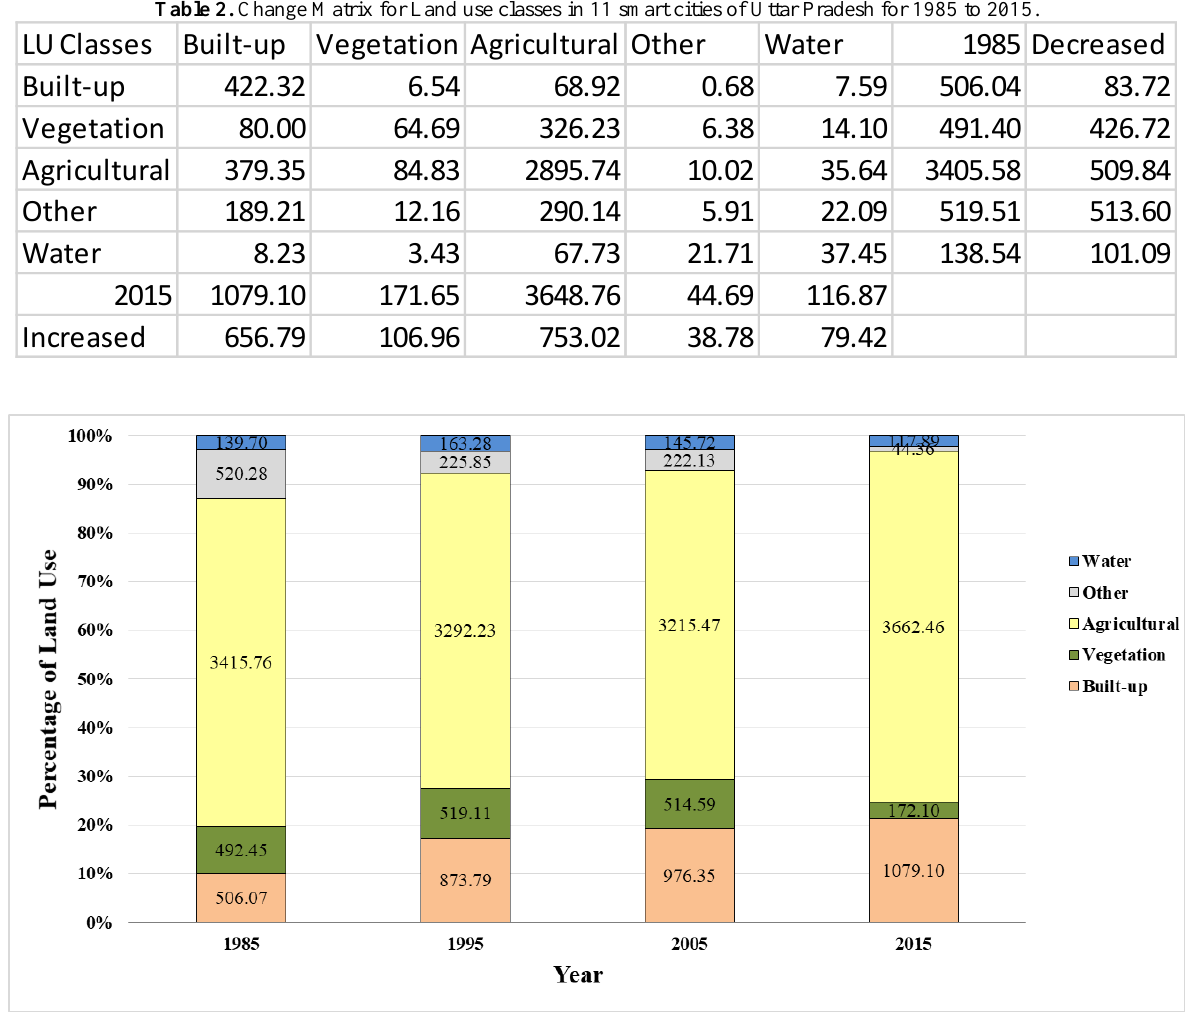
Figure 3. Land use change measured in study area of 11 smart cities of Uttar Pradesh